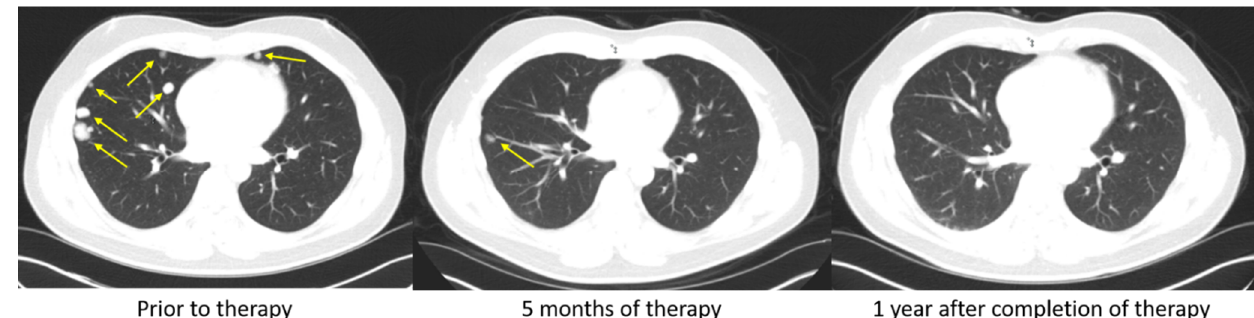
Figure 2. Complete response to PD-1 immune checkpoint inhibitors. A 48-year-old man with HBV cirrhosis developed a liver mass that was biopsied and found to be HCC. He underwent a laparoscopic partial right hepatectomy. Pathology revealed a poorly differentiated HCC, 3.3 cm in size, and margins were negative. On surveillance, he was found to have developed a rising AFP and to have bilateral lung nodules (Figure), but there was no evidence of recurrent or metastatic disease in the abdomen or pelvis. Biopsy of one of the pulmonary nodules confirmed metastatic disease and he was started on sorafenib. However, his disease progressed. He had no FGFR alteration, so he was started on nivolumab. After only 5 months of therapy, an objective response was seen on CT scan (middle). He completed a full year of therapy, and he remains without evidence of disease one year after completion of therapy.